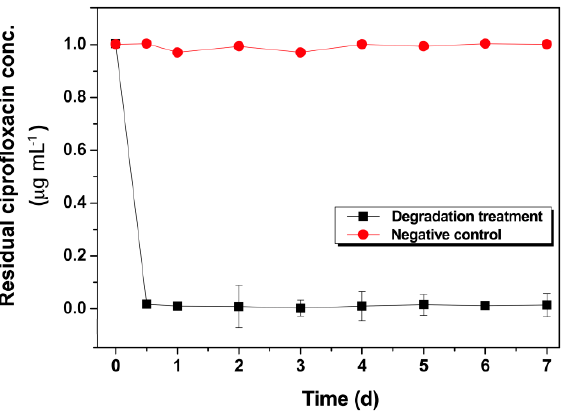
Figure 9. Degradation timecourse of CIP in natural lake water by the BMO